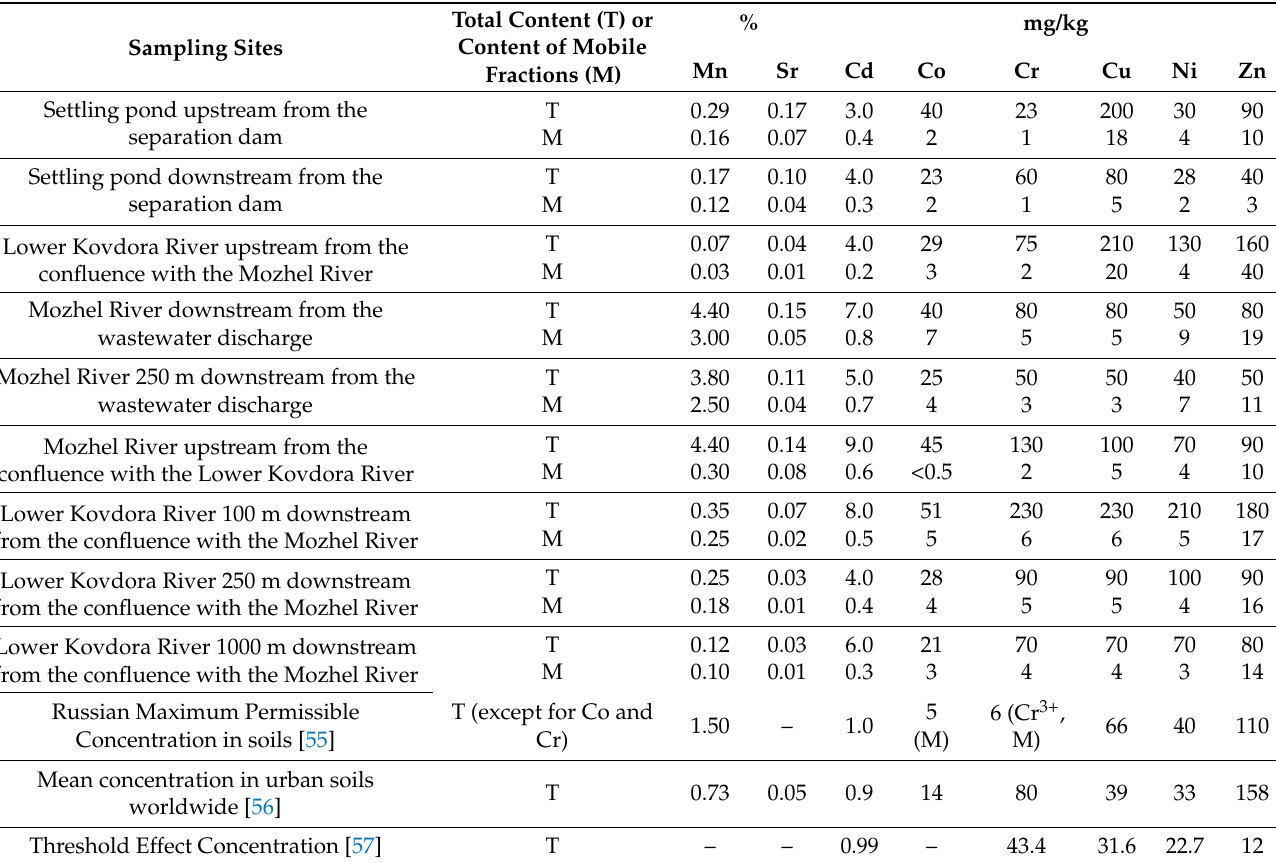
Table 5. Total and mobile element concentrations in the bottom sediments of natural and artificial aquatic ecosystems affected by the processing plant; reference concentrations in